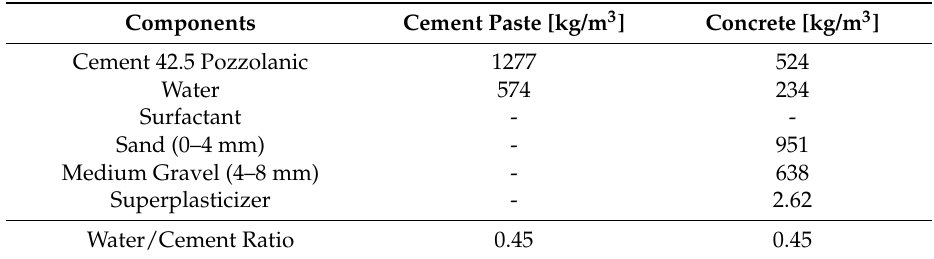
Table 1. Mix design of cement paste and concrete without carbon fillers relative to one cubic meter of self-sensing materials.